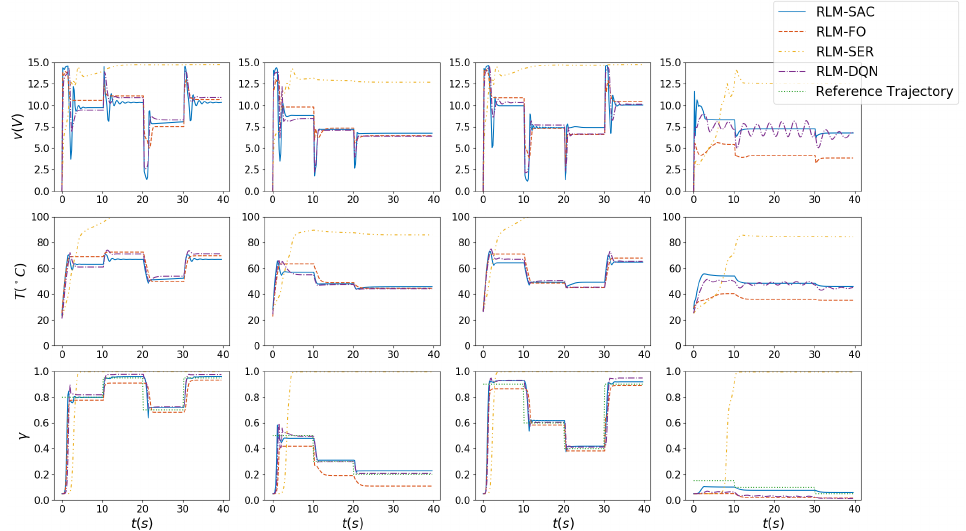
Figure 10. Voltages, temperatures and radius factors of control points. Each column represents the values of a